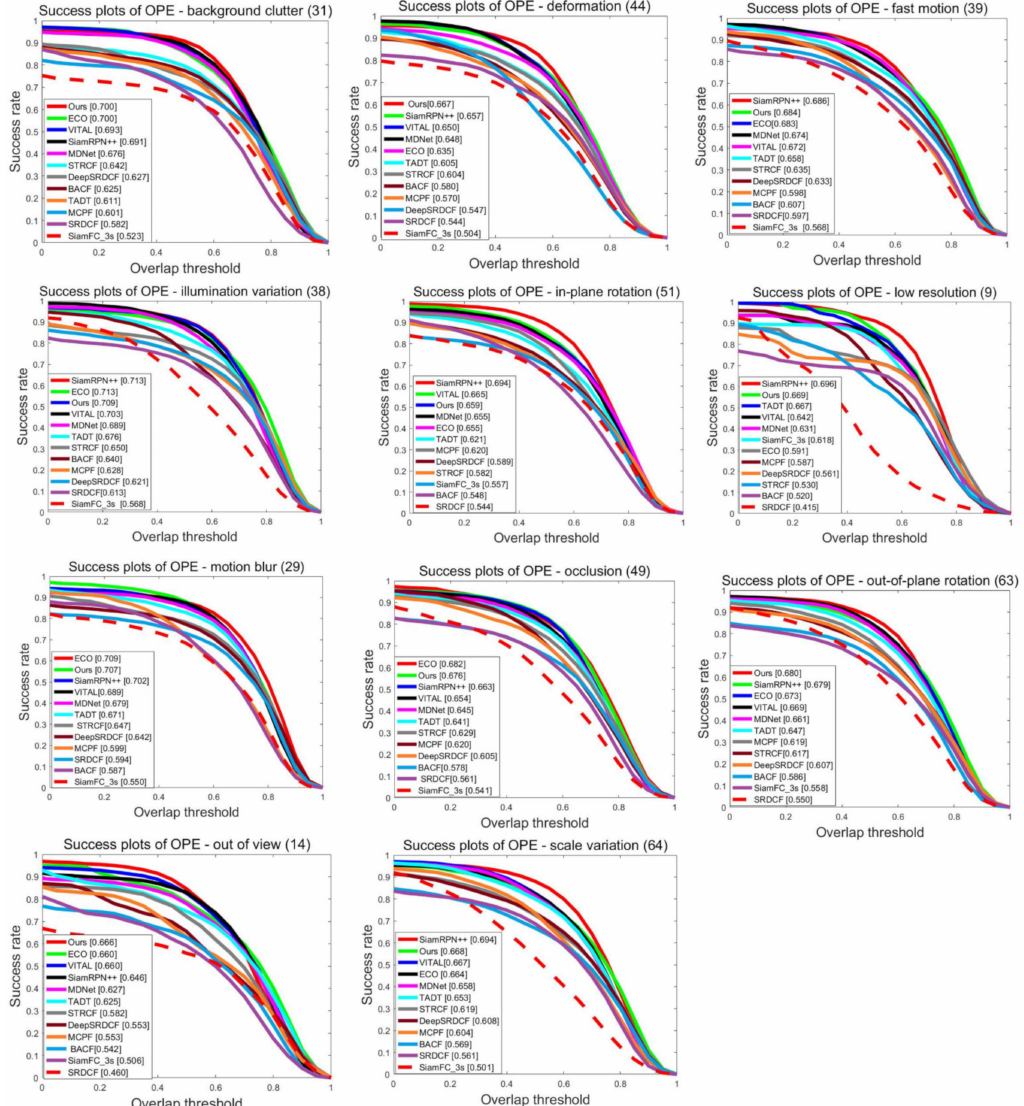
Figure 5. Success plots of OPE on eleven video sequence attributions of